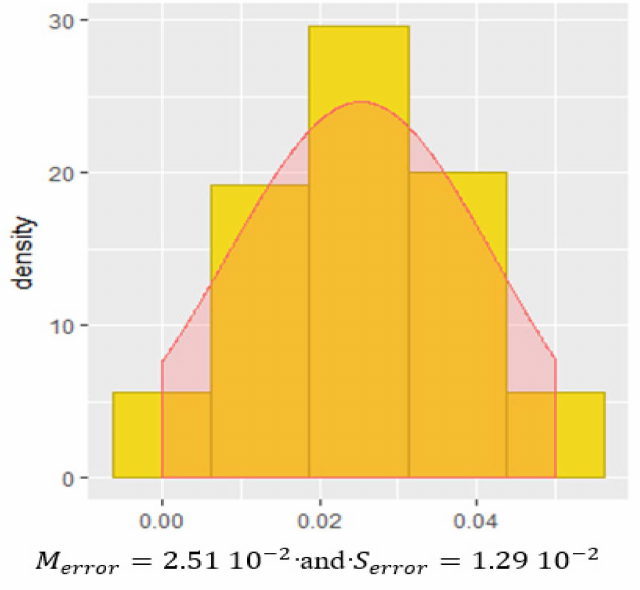
Figure 10. Accuracy of the ITCA